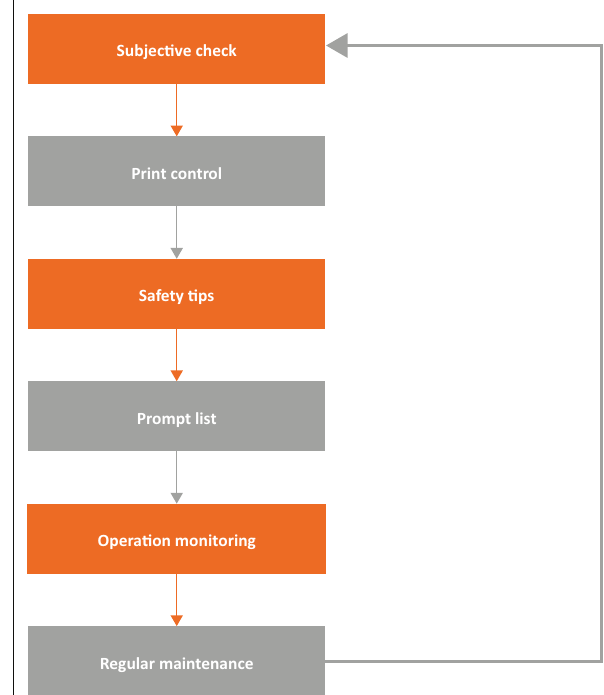
FIGURE 2: The flowchart diagram of quality control